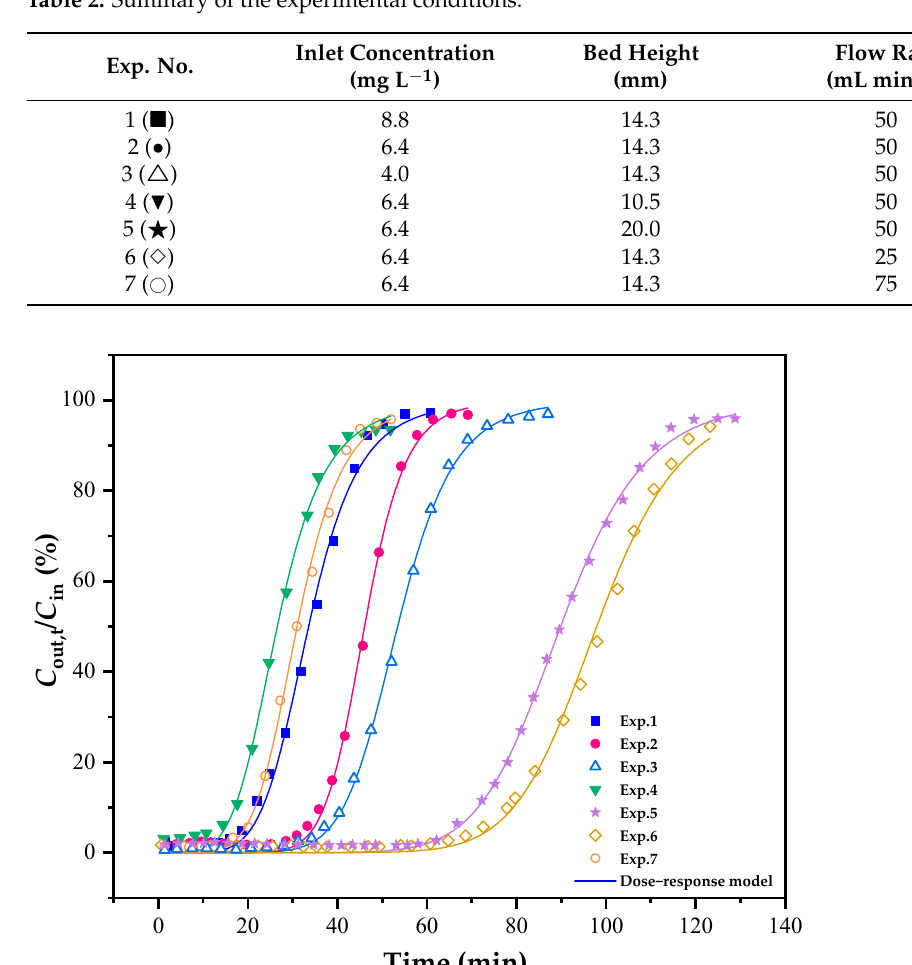
Table 2. Summary of the experimental conditions.